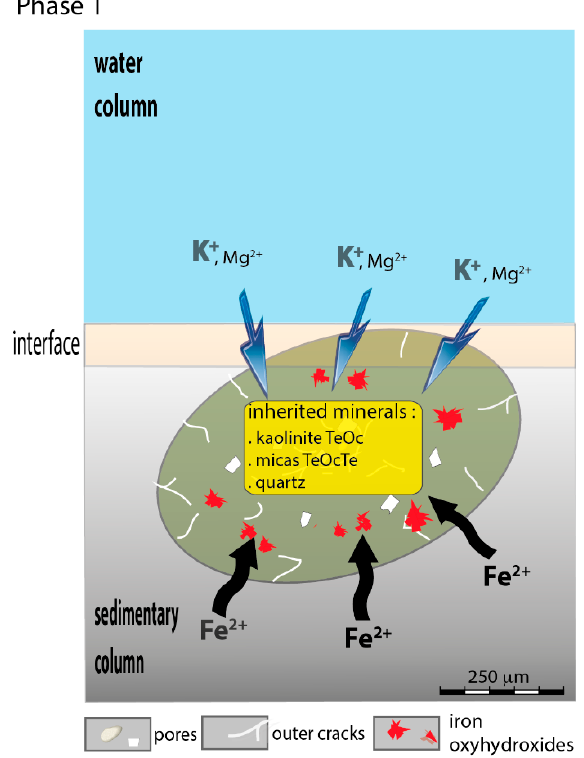
Figure 10. First phase of schematic evolution of glauconitic grains from pristine marine mud to pale–medium-green grains with the mean elementary composition measured by microprobe and established for each class color.